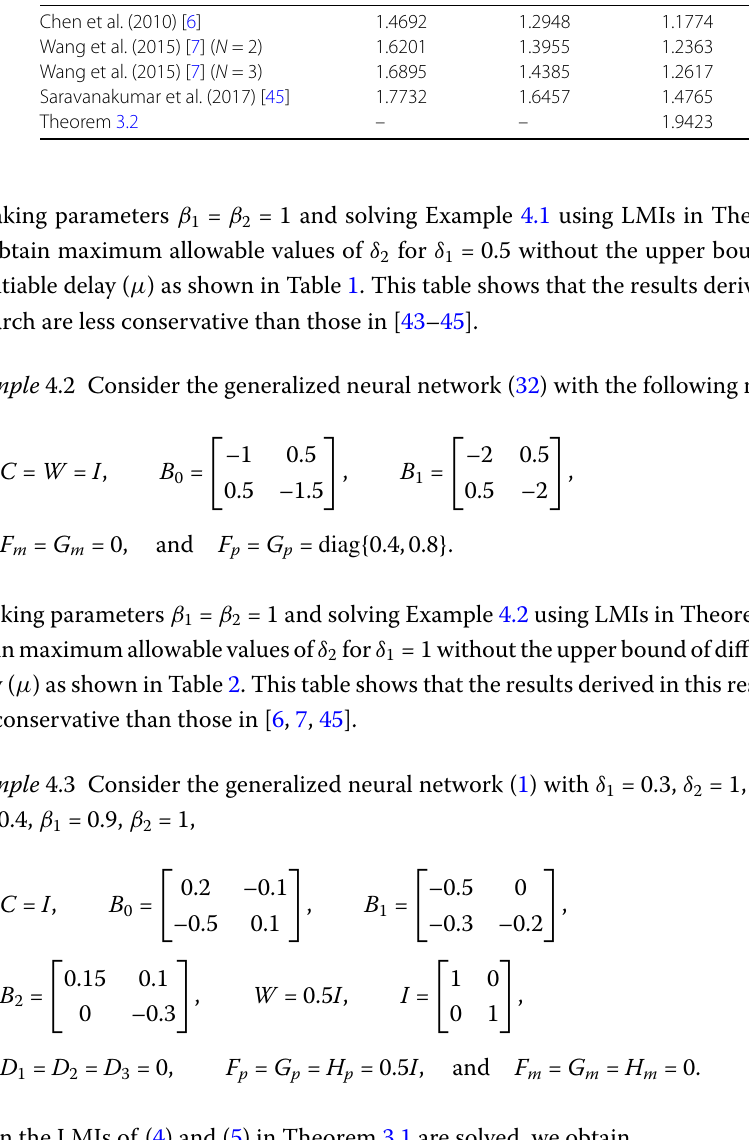
Table 2 The maximum allowable values of δ 2 for δ 1 = 1 and different values μ in Example 4.2